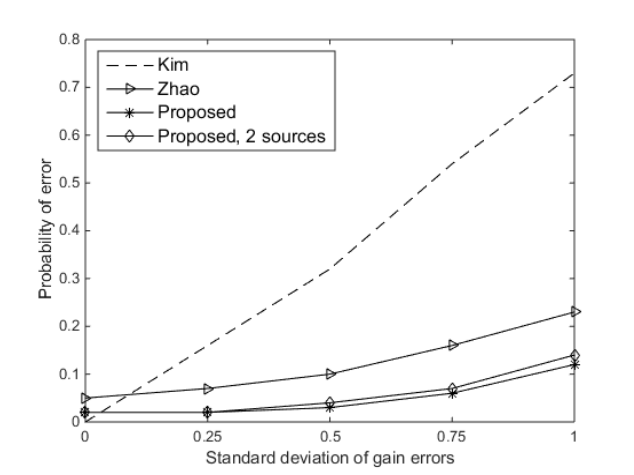
Figure 3. Probability of error versus the standard deviation of gain errors.